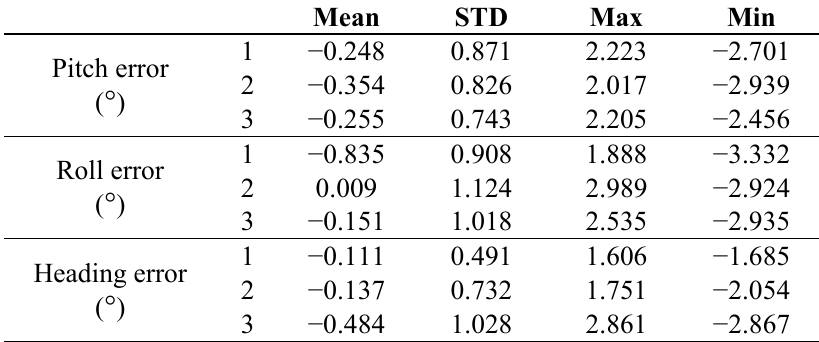
Table 4. Statistics of the second